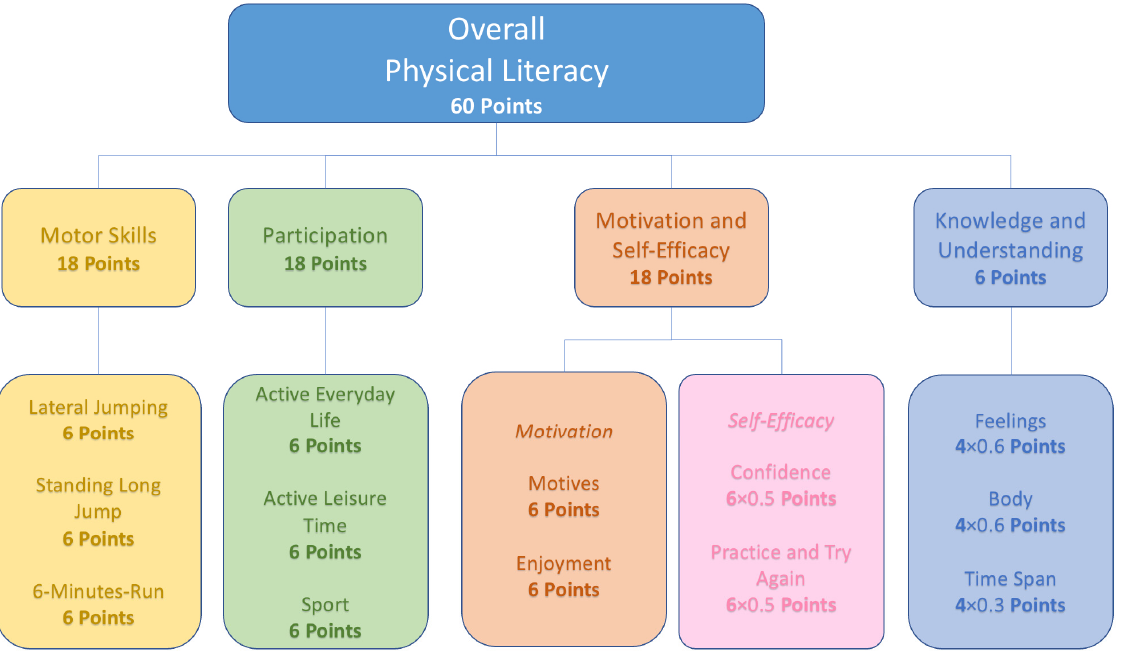
Figure 5. Scoring of the subdomains and weighted composition of the overall assessment of PL; the maximum achievable score is shown for each case.